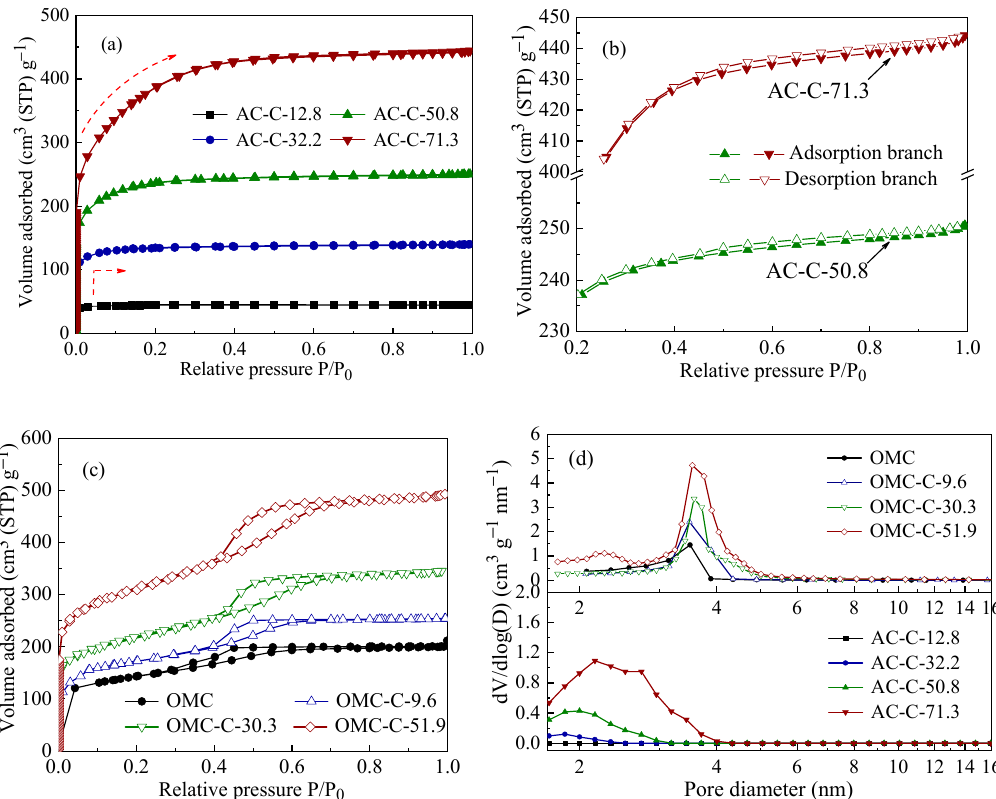
Figure 1. ( a – c ) N 2 adsorption and desorption isotherms at 77 K for the activated carbon (AC) and ordered mesoporous carbon (OMC) samples; ( d ) Barrett–Joyner and Halenda (BJH) mesopore size distribution plots of the AC and OMC samples. STP: Standard temperature and pressure. Table 1. The pore microstructural characteristics and elemental analysis of the samples. Sample